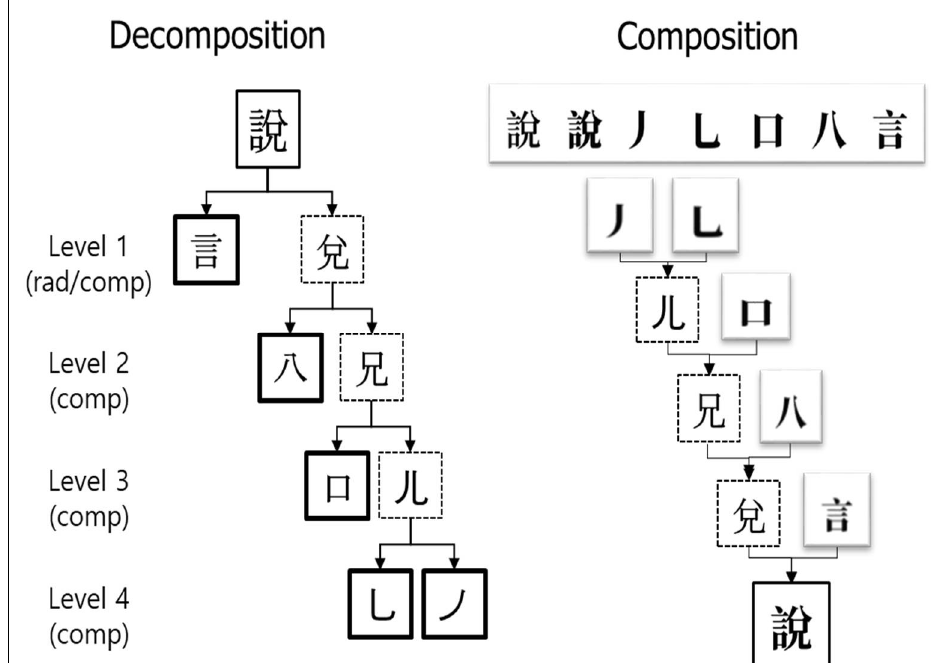
Figure 8. An example of character decomposition and composition.